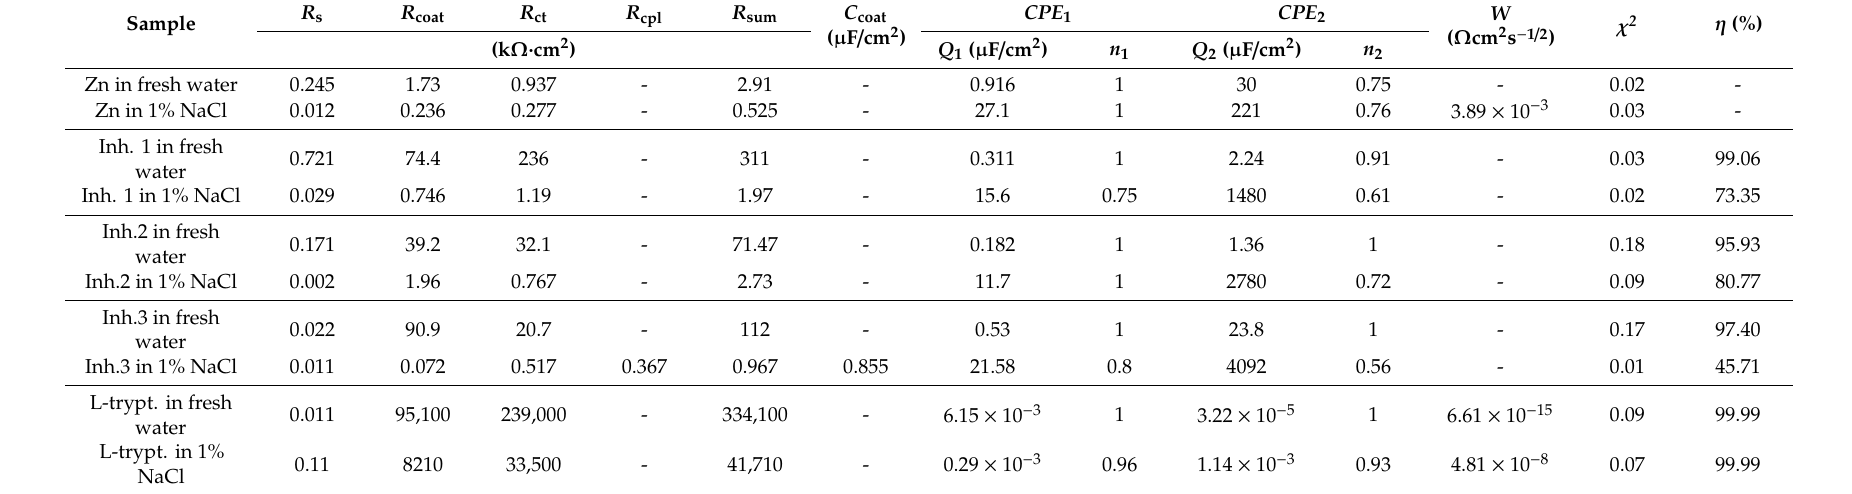
Table 7. EIS results after 24 h immersion in fresh water and 1% NaCl, with and without